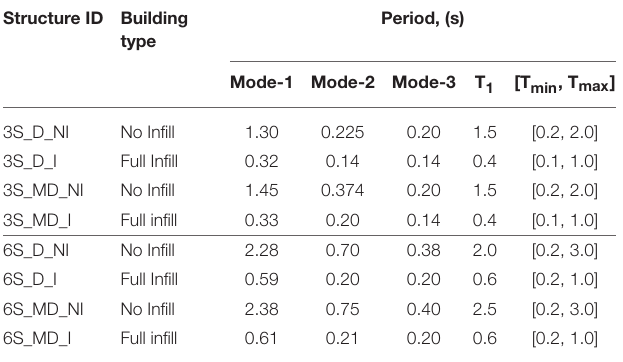
TABLE 2 | First three fundamental periods of 3 − and 6 − story RC MRF buildings. Structure ID Building type